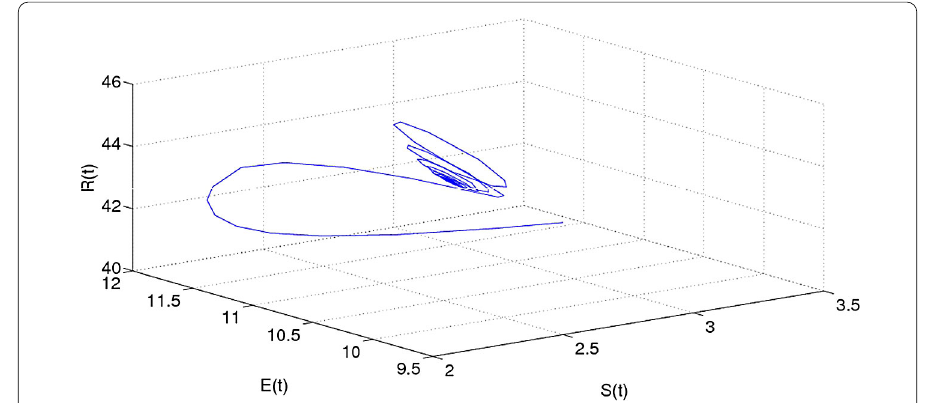
Figure 1 Dynamic behavior of system (63): projection on S-E-R with τ =